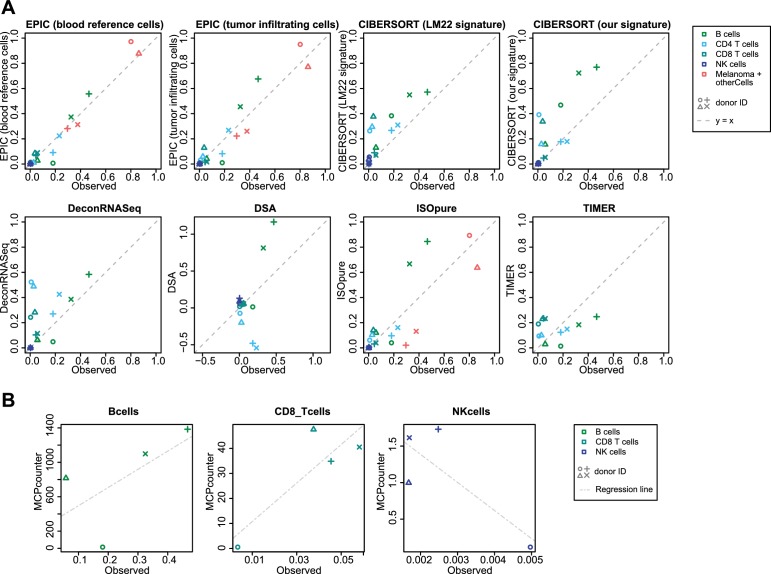
Comparison of cell fraction prediction methods with flow cytometry data of melanoma tumors.(A) Comparison directly of all cell types together. When a cell type could not be predicted by a given method, this cell type is absent from the subfigure. (B) Comparison per cell type for MCP-counter as the predictions are not comparable across different cell types. CD4 T cells and melanoma cell proportions are not predicted by MCP counter. Correlation and RMSE values are available in Figure 5—figure supplement 1.